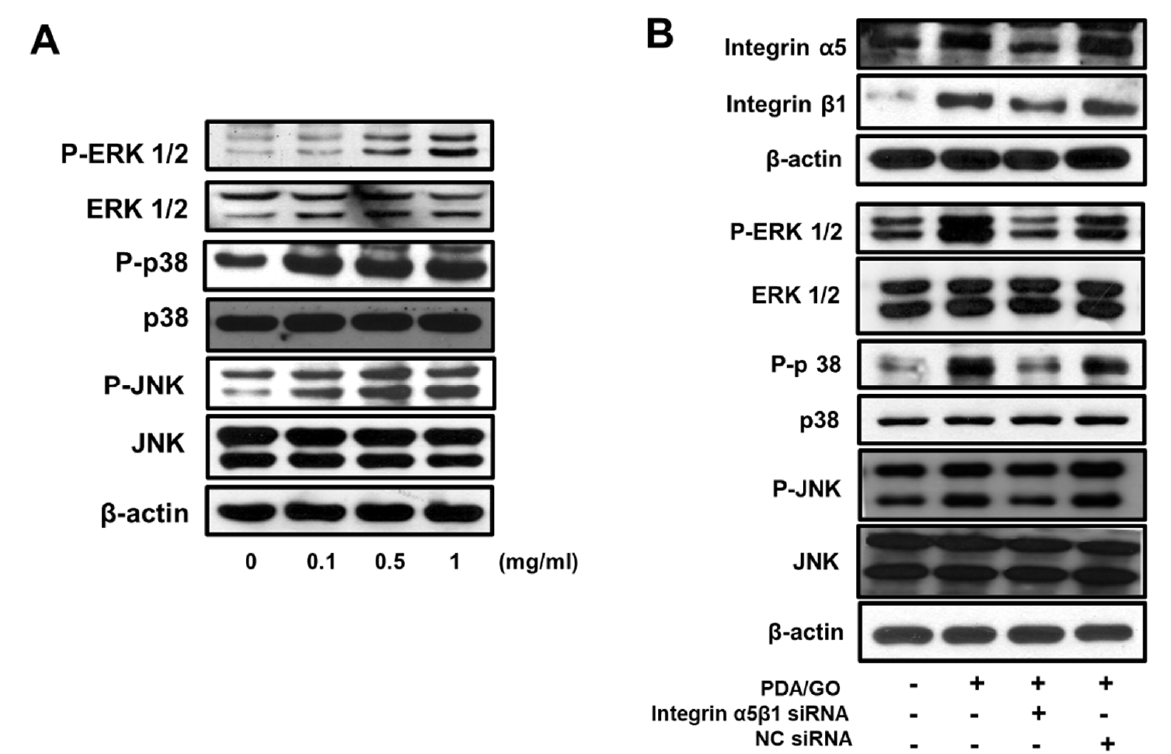
Figure 5. Effect of PDA/GO on MAPKs signaling pathways. The cells were cultured on the PDA/GO substrate for 7 days and ( A ) Phosphorylation of ERK1/2 (42–44 kDa), p38 (38 kDa), and JNK (46–54 kDa) was assessed. ( B ) Cells were transfected with integrin α 5/ β 1-specific siRNA, and the protein levels of integrin α 5, β 1, and the ERK1/2, p38, and JNK phosphorylation levels were examined after 4 days of osteogenic induction.